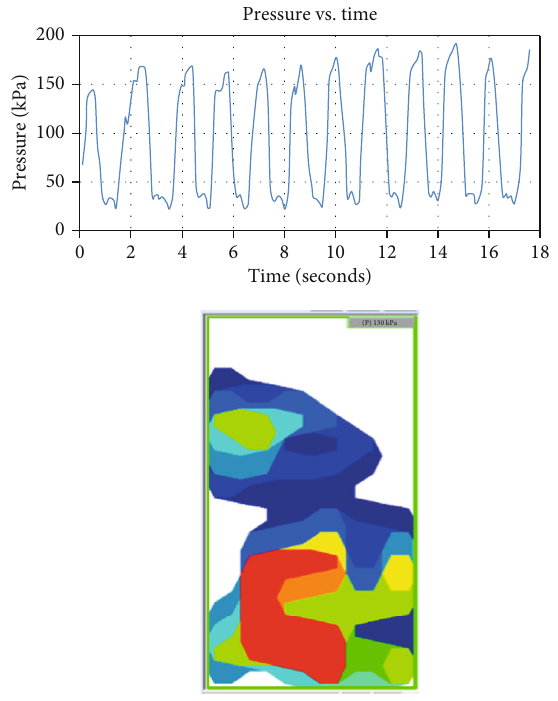
Figure 13: Pressure with time at the medial